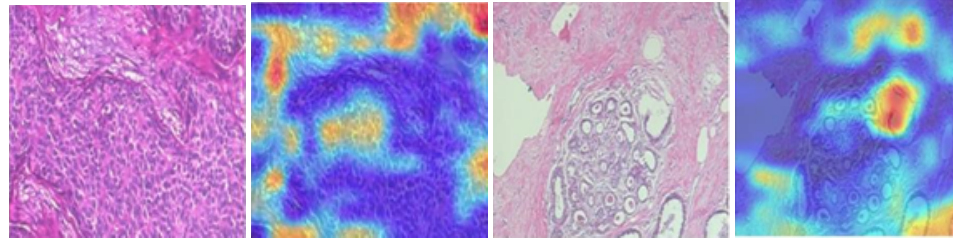
Figure 14. Sample heatmaps of regions of interest generated by grad-cam (left pair = malignant original image and grad-cam heatmap, right pair = benign original image and grad-cam heatmap.